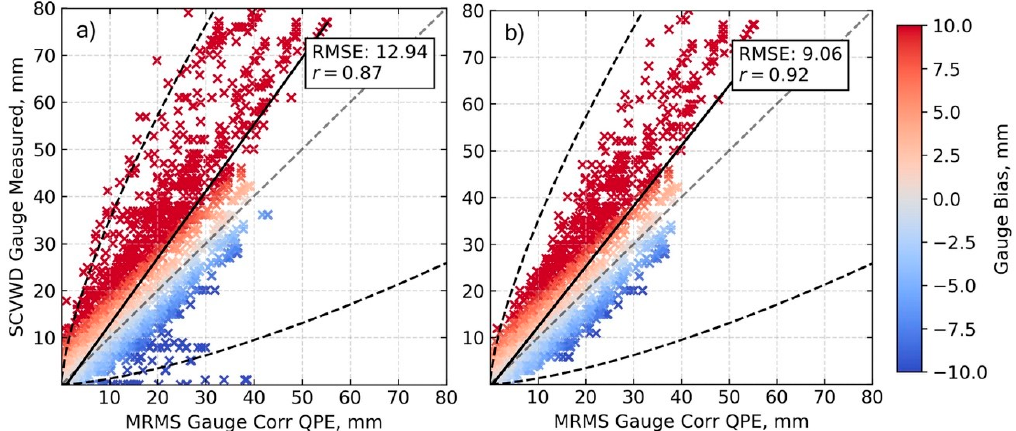
Figure 3. MRMS vs. SCVWD hourly accumulated precipitation for both events ( a ) before QC; ( b ) after QC. Dark dashed lines are bounding equations from Qi et al. [29].